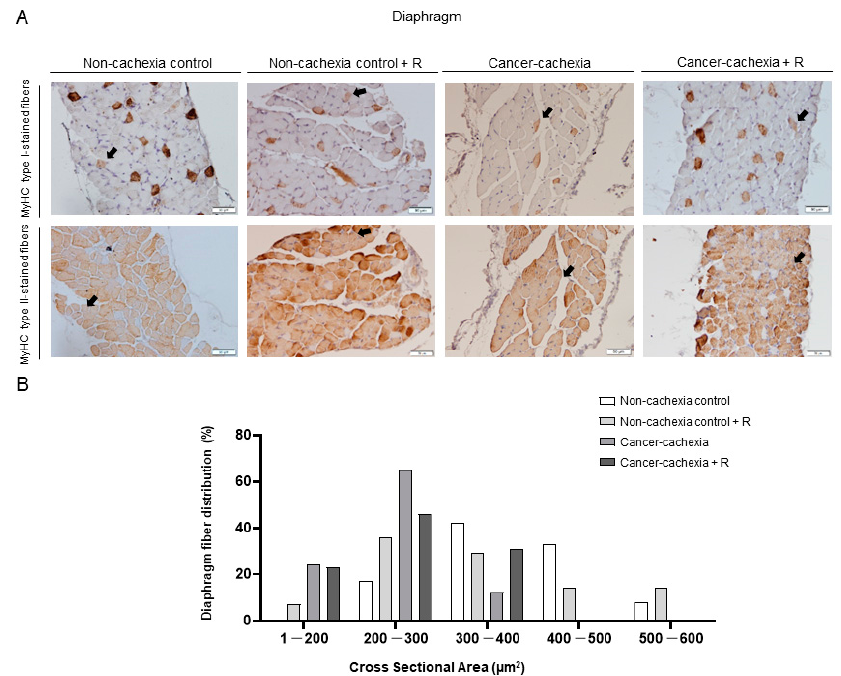
Figure 5. Representative images of diaphragm muscle fibers ( A ). Myofibers with anti-MyHC type I antibody staining (brown color) are shown in the top panel and anti-MyHC type II antibody staining in the middle panel. Hybrid fibers (arrows) are seen in both panels. Schematic representation of the distribution of the CSA of the muscle fibers in the diaphragm muscle ( B ). Abbreviations: R, rucaparib; MyHC, myosin heavy chain; CSA, cross-sectional area.